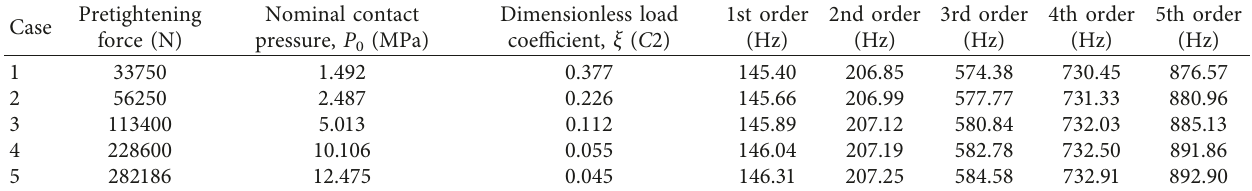
Table 4: Calculated results of flexural vibration modal frequencies of the experimental rod-fastened